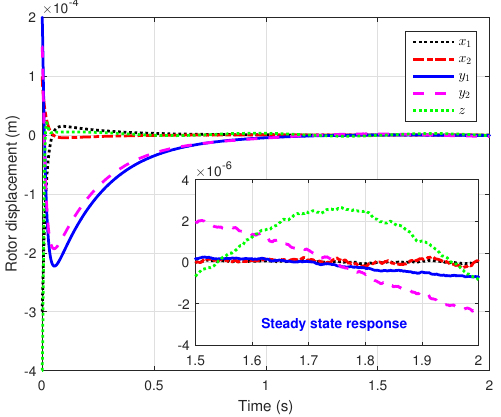
Figure 8. The responses of rotor positions under PID